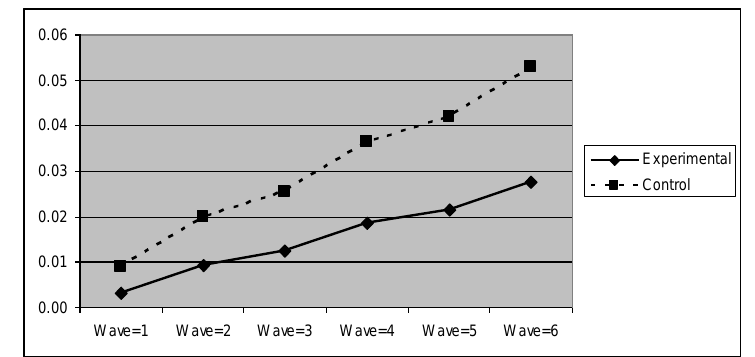
FIGURE 1 . Growth trajectories of the experimental group (participants who joined the Tier 1 Program only) and control group using the item score of ketamine use as the outcome indicator.